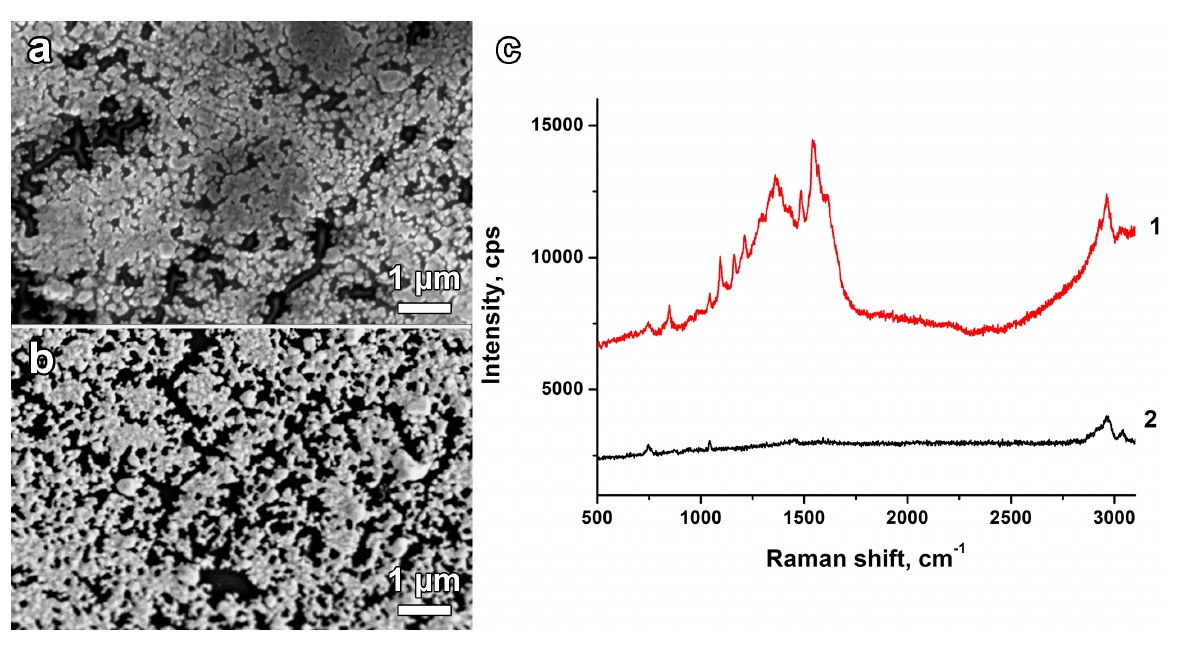
Figure 6: Micrographs of mp-Ag/Ag slides prepared in the presence of PVP after sintering for 1 h in air at (a) 110 °C and (b) 120 °C. (c) Raman/SERS spectra of meldonium (probe: dried 2 μ L probe of 1 × 10 − 2 M concentration) after sintering at (1) 110 °C and (2) 120 °C for 1 h in air. The excitation laser wavelength was 514.4 nm, at 5% power of 20 mW, and 10 s acquisition